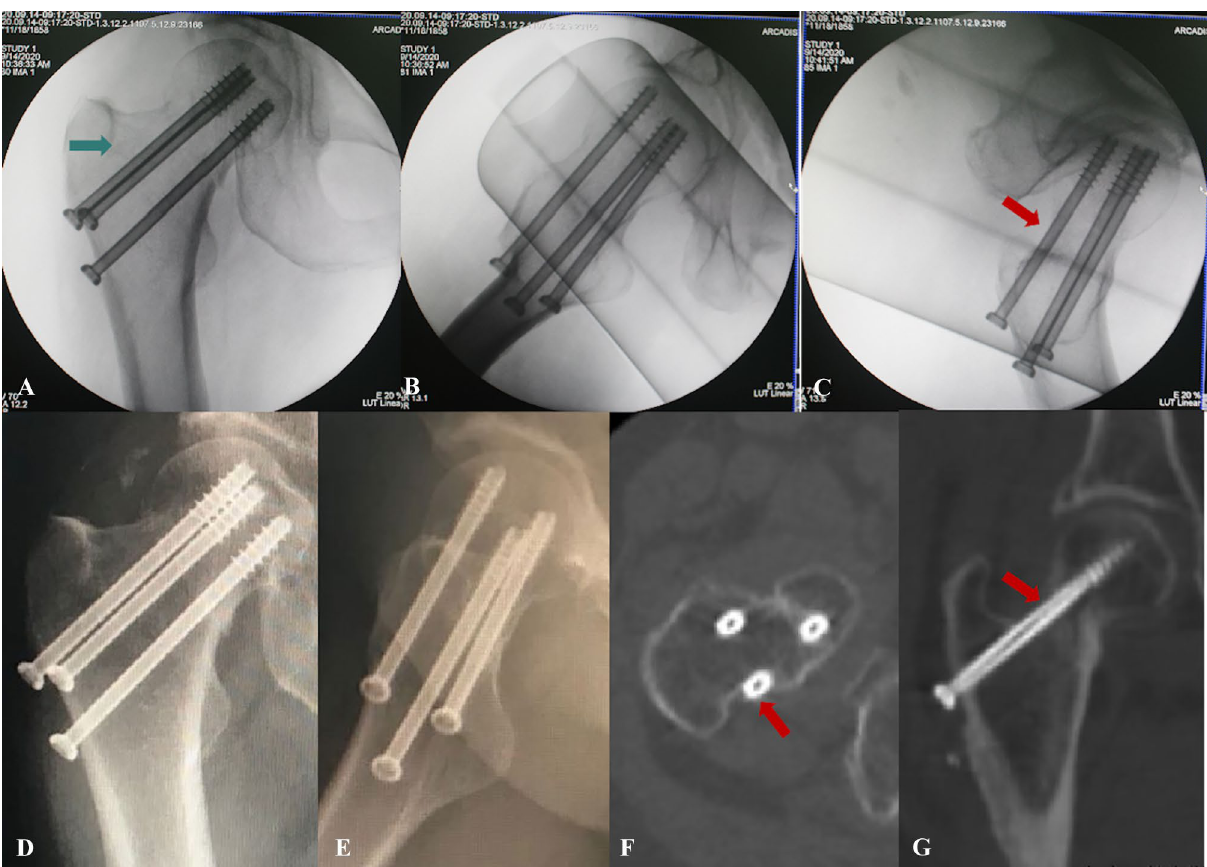
Figure 3. The posterosuperior femoral neck screw placed caudal to the inferior margin of the piriformis fossa in–out–in. The green arrow represents the piriformis fossa radiographic landmark. The red arrow represents the posterosuperior femoral neck screw IOI. ( A , B ) Intra-operative the AP and lateral views showed all screws were contained within the femoral neck. ( C ) Intra-operative the tangential view showed the posterosuperior screw IOI. ( D , E ) Postoperative plain radiographs showed all screws were contained within the femoral neck. ( F , G ) Postoperative CT showed the posterosuperior femoral neck screw IOI.